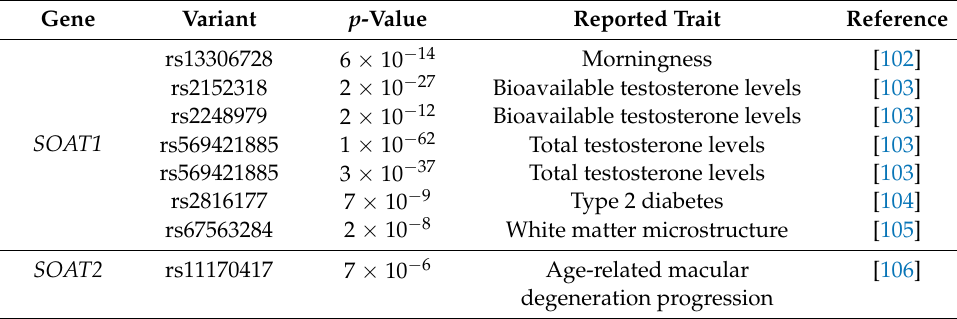
Table 2. GWAS findings for human SOAT1/2